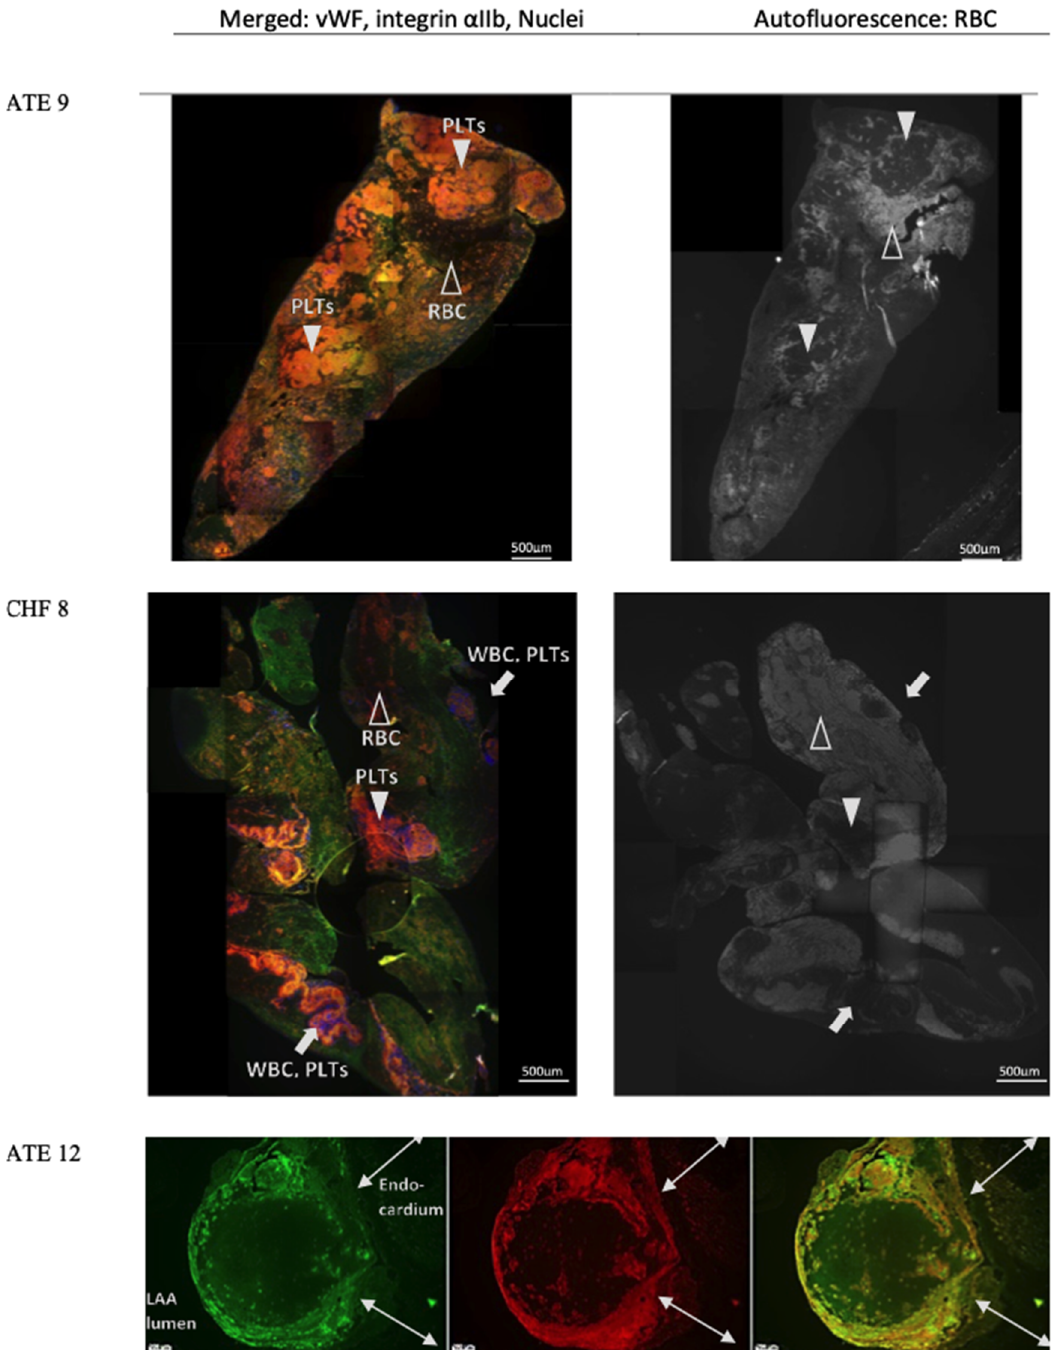
Figure 6. Microscopic images of thrombi immunostained for vWF and integrin α IIb: Images from Cats ATE 9, CHF 8: Images on the left shows the merged channels of vWF (green), platelet marker integrin α IIb (reddish orange) and nuclei (blue). In the merged channel, bright orange colour (closed arrow heads) represented clumps of platelets and vWF, while the RBC appeared dark and non-fluorescent (open arrow heads) compared to the immunolabelled vWF and platelets. WBCs were identified based on the blue colour of their nuclei and could be observed with platelets in clumps (arrows). Images were collated to show the whole thrombus. Images from Cat ATE 12: Split channels from left to right showed vWF in green, platelet marker integrin α IIb in red and the merged of the two channels. This thrombus remained in situ in the LAA. vWF and platelets encompassed RBC and connected to the endocardium. 50 × magnification; bar = 200 µ m. RBC, red blood cells; PLT, platelets; WBC, white blood cells; LAA, left atrial appendage.